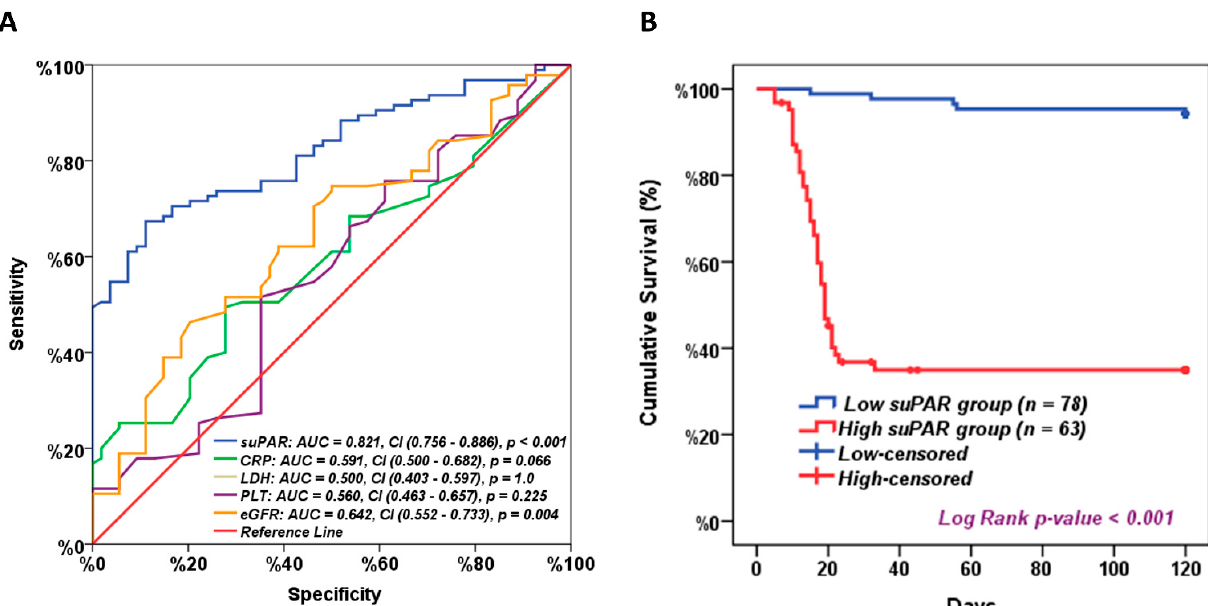
Figure 5. suPAR as a prognostic marker. ( A ) Receiver operating characteristic curve analysis for suPAR level for discriminating patients with bad COVID-19 prognosis from those with good prognosis. AUC: area under the curve. CI: Confidence Interval 95%, and ( B ) Kaplan–Meier survival analysis for all patients based on median suPAR level. p -value < 0.05 was considered statistically signi fi cant.